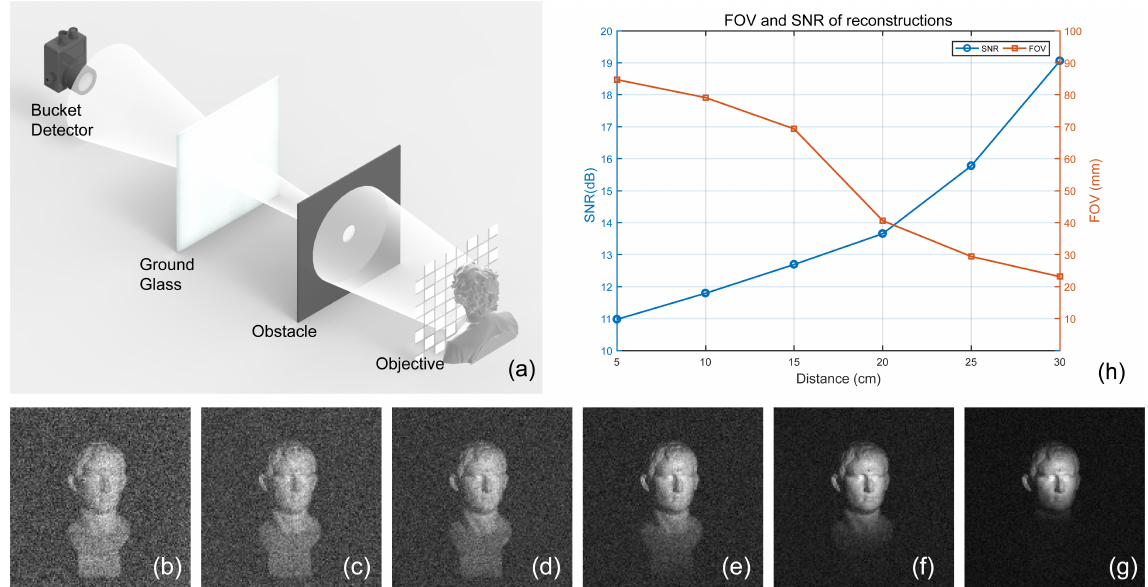
Figure 4. ( a ) Schematic diagram of detection part which enlarges the restricted FOV of SPI by scattered light. FOV is restricted by the iris of 1cm diameter, which is placed 35 cm away from the object in the detection part and therefore 25 cm from the detector. Ground glass is inserted between the iris and bucket detector to generate scattered light. The ground glass is moved from a position clinging to the iris towards the bucket detector with a distance of 5 cm at each movement. ( b – g ) The reconstructions of gradually moving the ground glass away from the iris to bucket detector and the distance of every movement is 5 cm. ( b ) is the result when the ground glass clings to the iris. ( g ) is the result when the ground glass clings to bucket detector. ( h )The SNR and linear FOV of reconstructions with respect to the distance between ground glass and